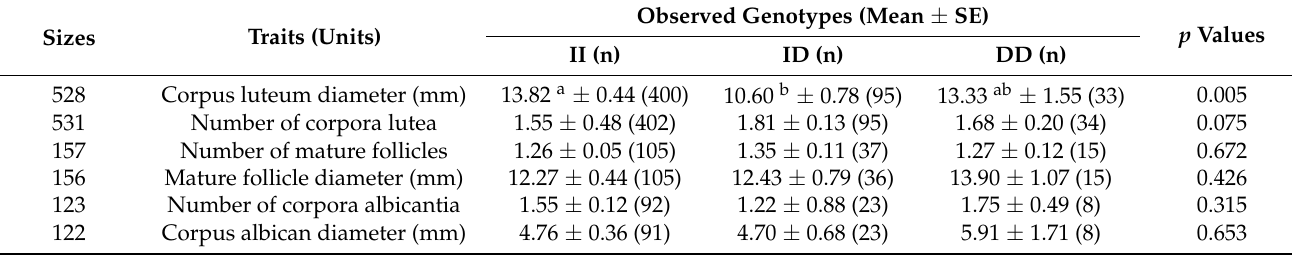
Table 4. Relationships between P1-D 13-bp of ITG β 5 and corpus luteum traits, mature follicle and corpus albican traits of the bovine